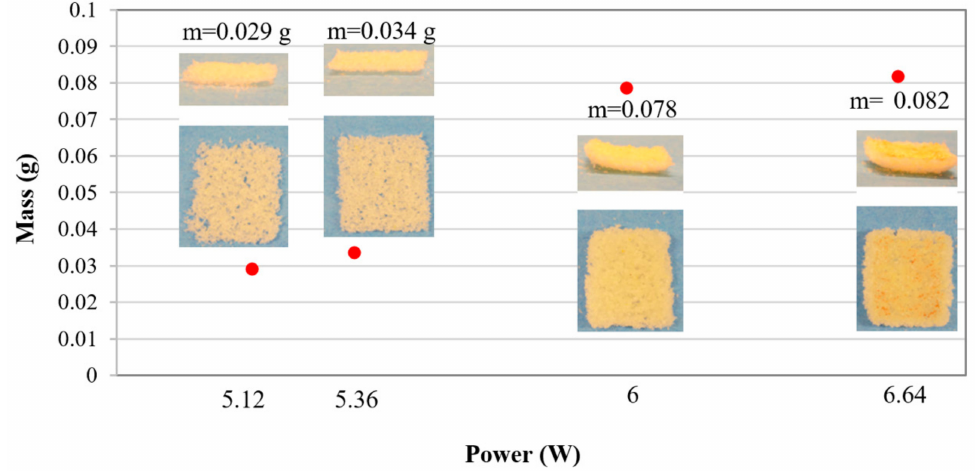
Figure 8. The e ff ect of power increment on the amount of fused material and distortion of 1 cm primitive layers. The process was performed at focal distance = 51 mm, laser scan speed = 150 mm / s, and line spacing = 100 µ m. The images on the graph show the side and top view of the primitive layers.